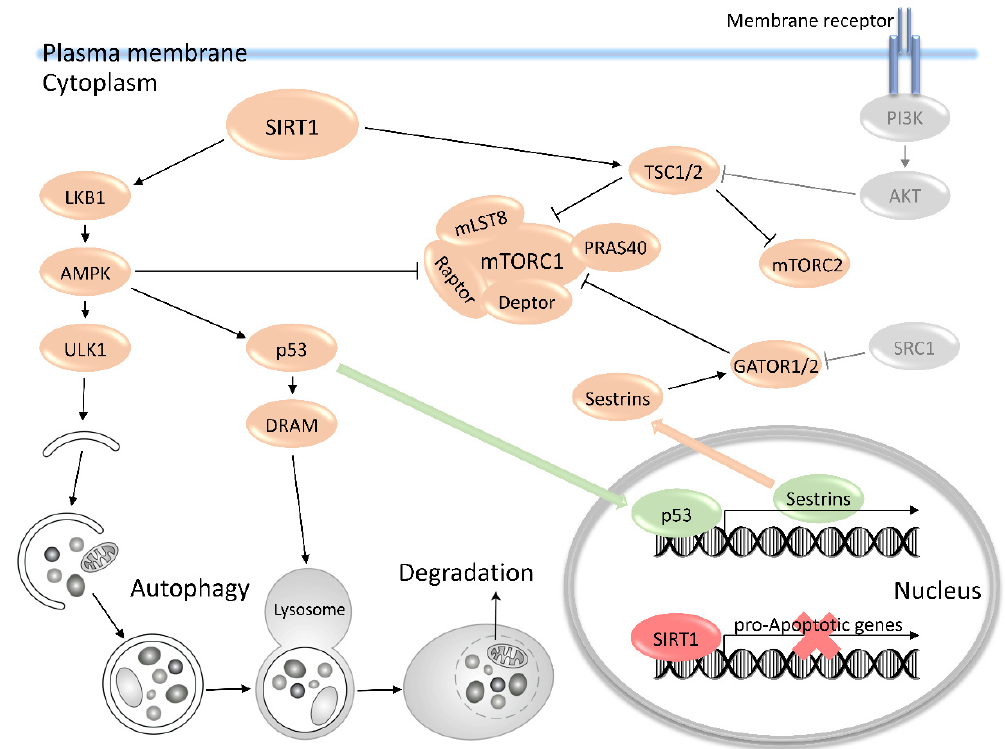
Figure 2. The mTOR pathway profile in ESCs; generalized chart. The PI3K/AKT signaling activates mTOR kinase